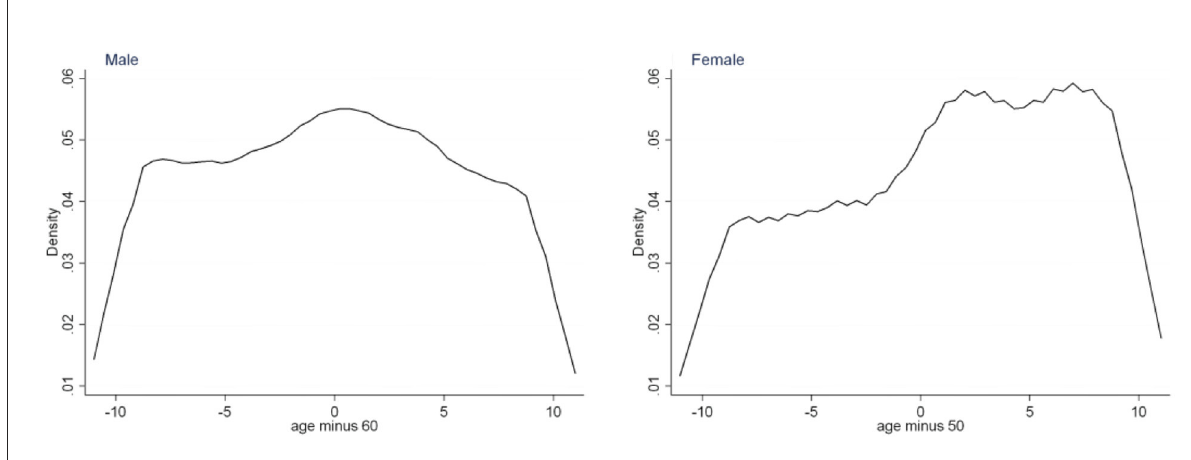
FIGURE2 Density distribution of